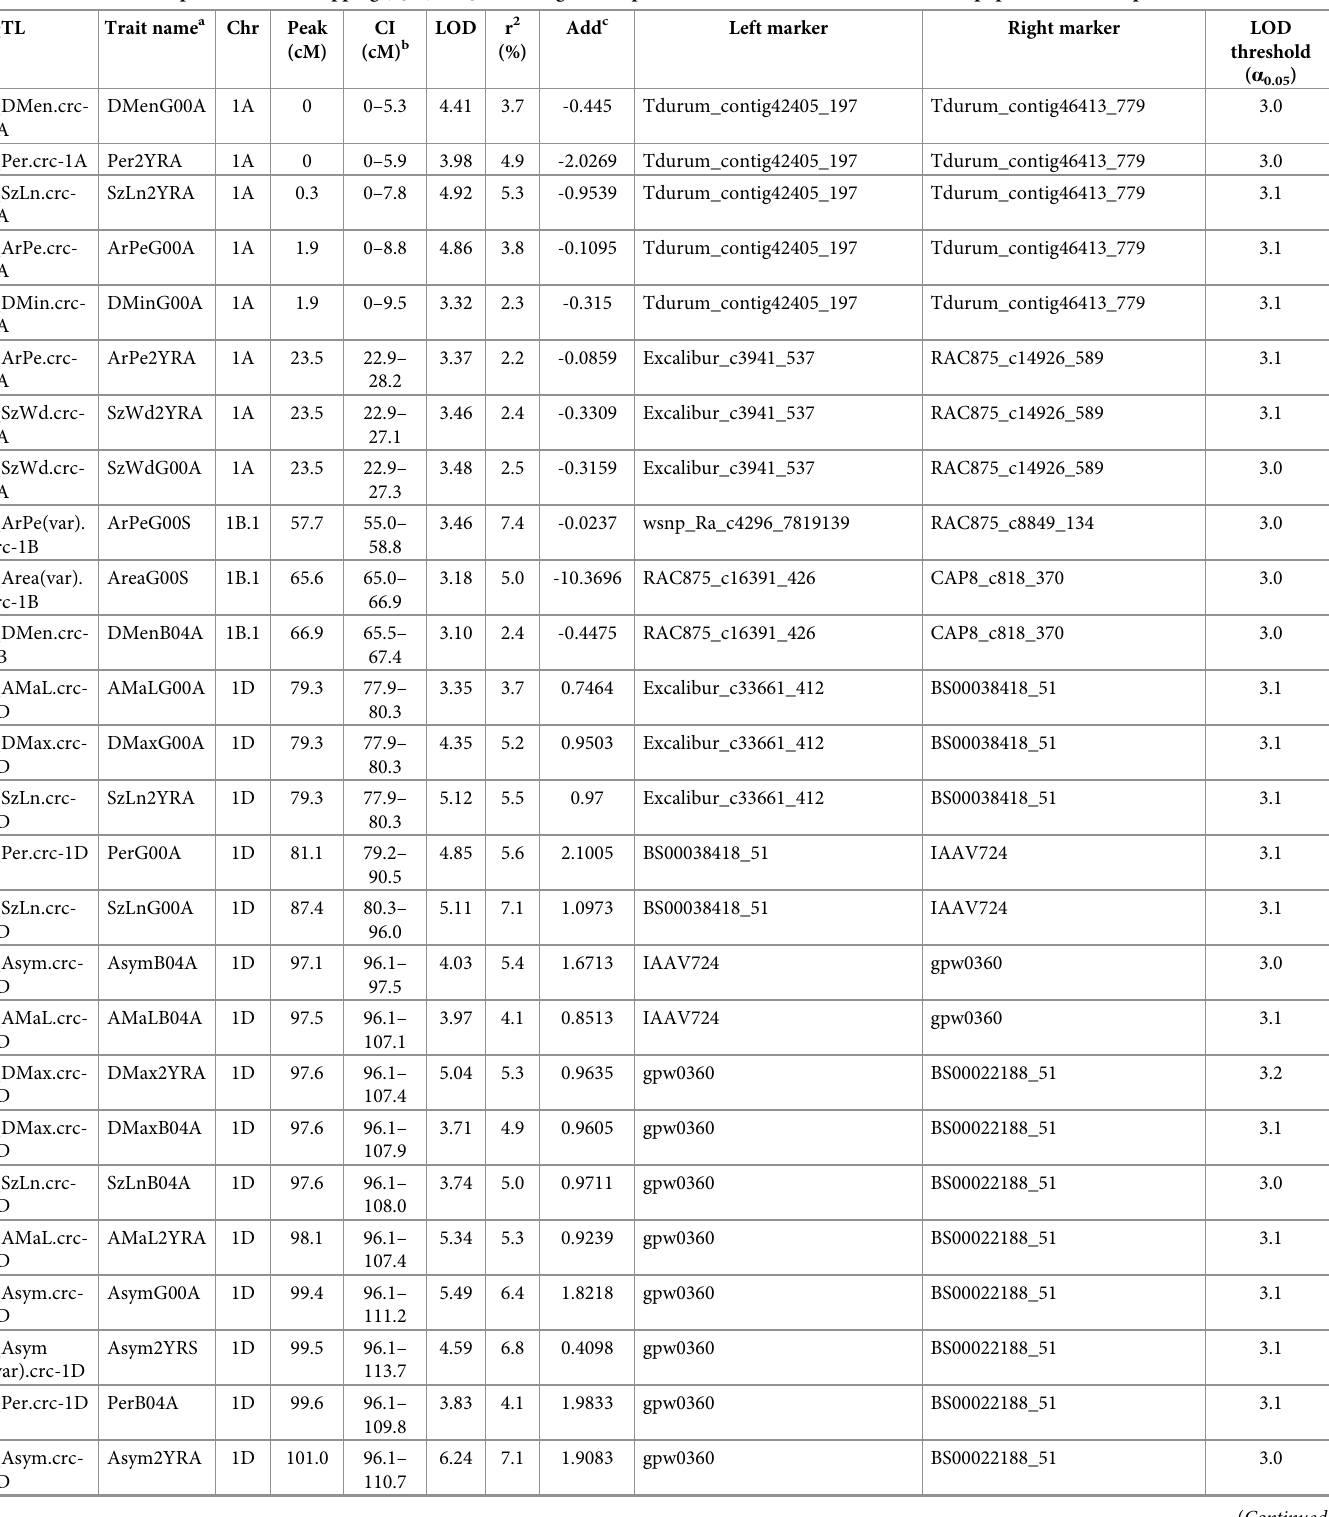
Table 3. Inclusive Composite Interval Mapping (QIC) of QTL for 14 grain shape traits in the RL4452/‘AC Domain’ DH population from replicated